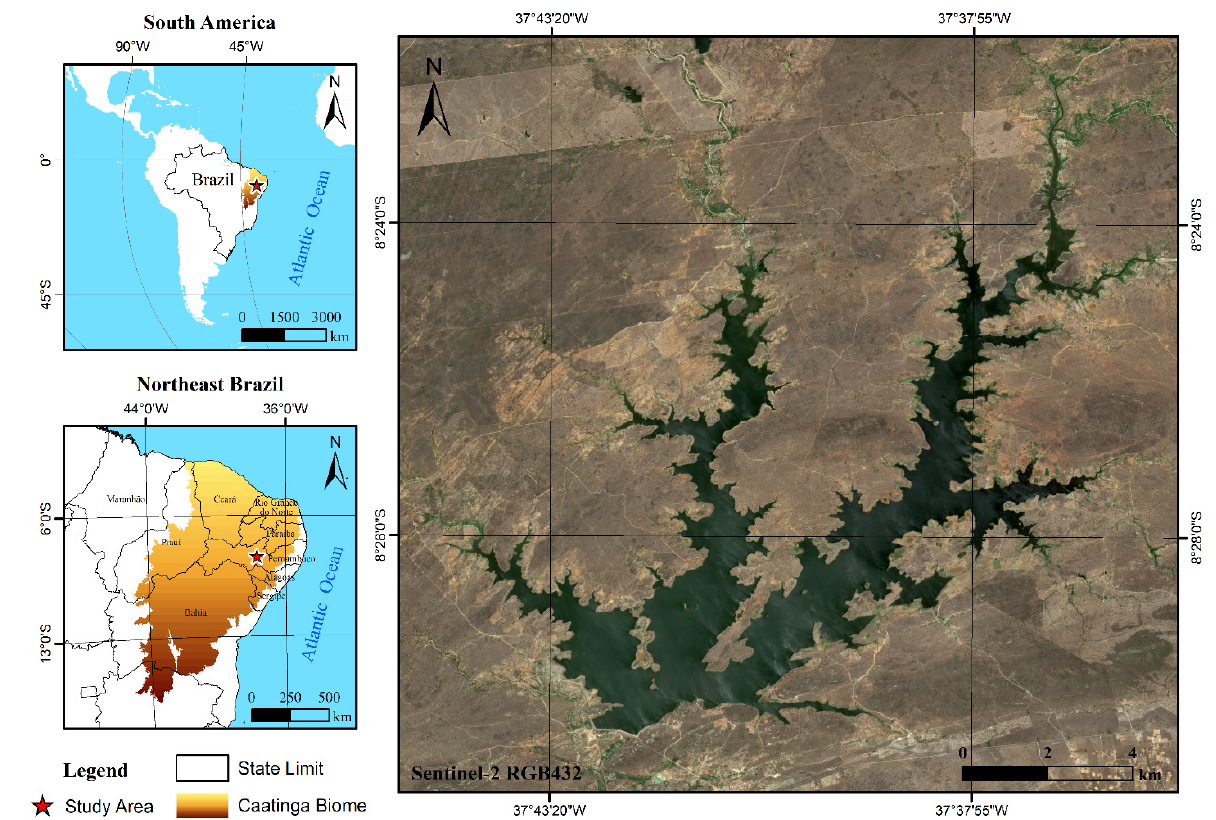
Figure 1. Location map of the test area.